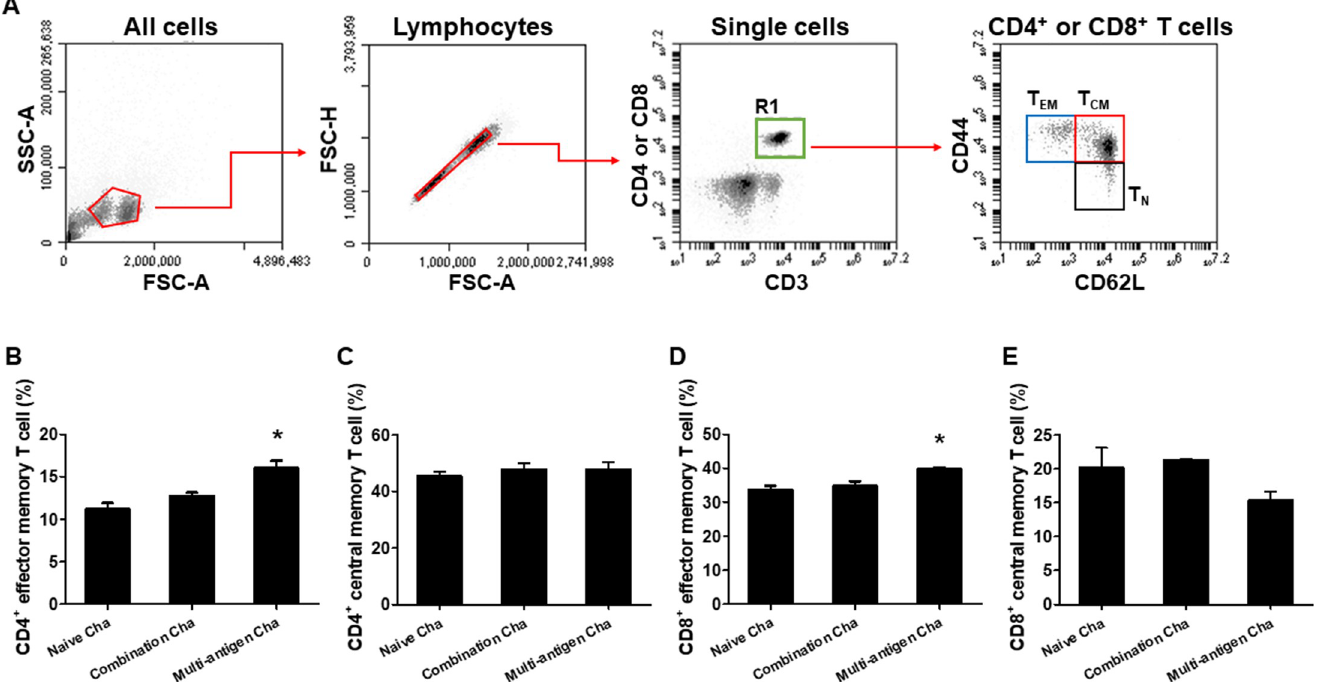
Fig 4. Memory T cell response. Flow cytometry plots showing the gating strategy to identify memory T cell subsets (A). The CD4 + and CD8 + effector memory T cells were separated by CD3 + , CD4 + , CD44 + and CD62L - and CD3 + , CD8 + , CD44 + and CD62L - staining. Significantly higher level of CD4 + and CD8 + effector memory T cell was found in multi-antigen VLPs immunized mice (Multi-antigen Cha) compared to combination VLPs immunized mice (Combination Cha) or na ï ve challenged mice (Na ï ve Cha) (B and D, � P < 0.01). The CD4 + and CD8 + central memory T cells were separated by CD3 + , CD4 + , CD44 + and CD62L + and CD3 + , CD8 + , CD44 + and CD62L + staining. There was no significant difference among the mice groups